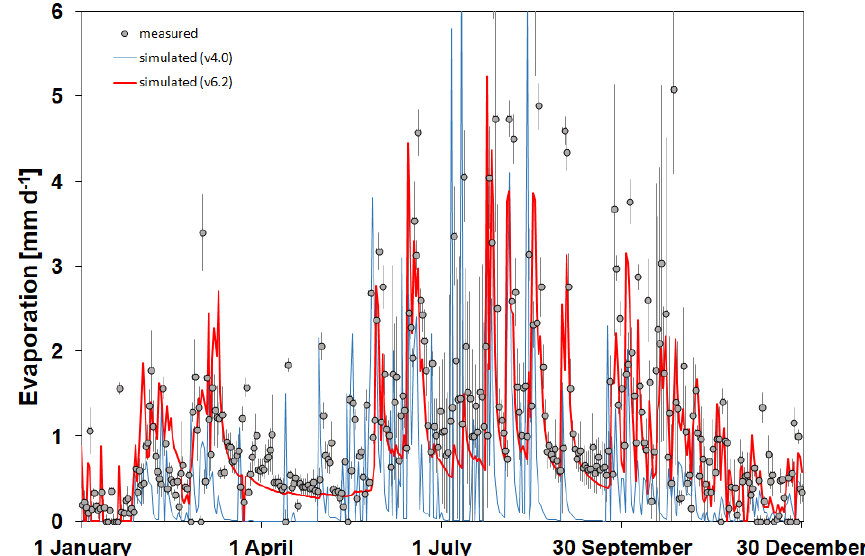
Figure 7. The simulated (blue line: v4.0; red line: v6.2) and observed (grey dots) daily soil evaporation values at Martonvásár during 2020. Vertical grey lines associated with the observations represent the standard deviation of the observations from six lysimeter columns. The improved model clearly outperforms the earlier version.